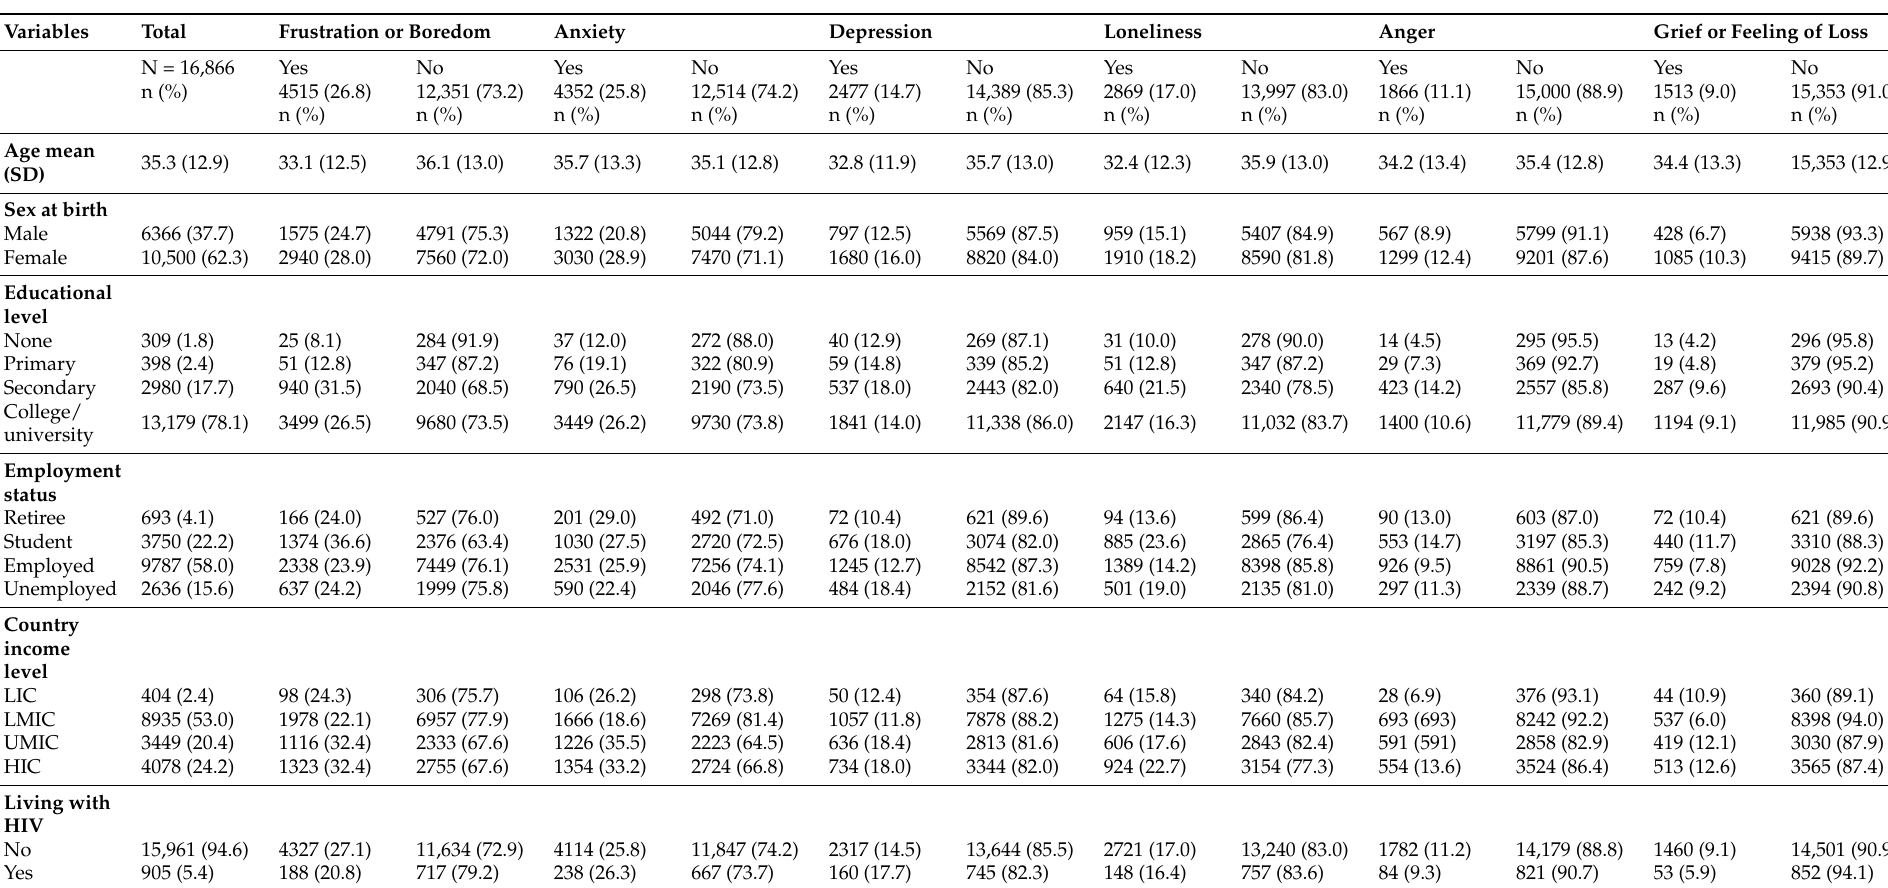
Table 1. Descriptive statistics of the dependent, independent, and confounding variables associated with HIV status in a multicountry sample of study participants (N =